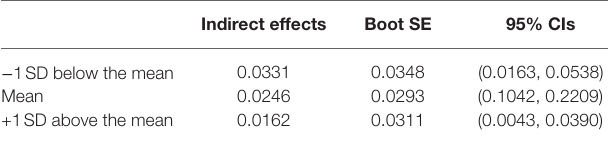
TABLE 6 | Indirect effects of the moderated chained mediation analyses. Indirect effects Boot SE